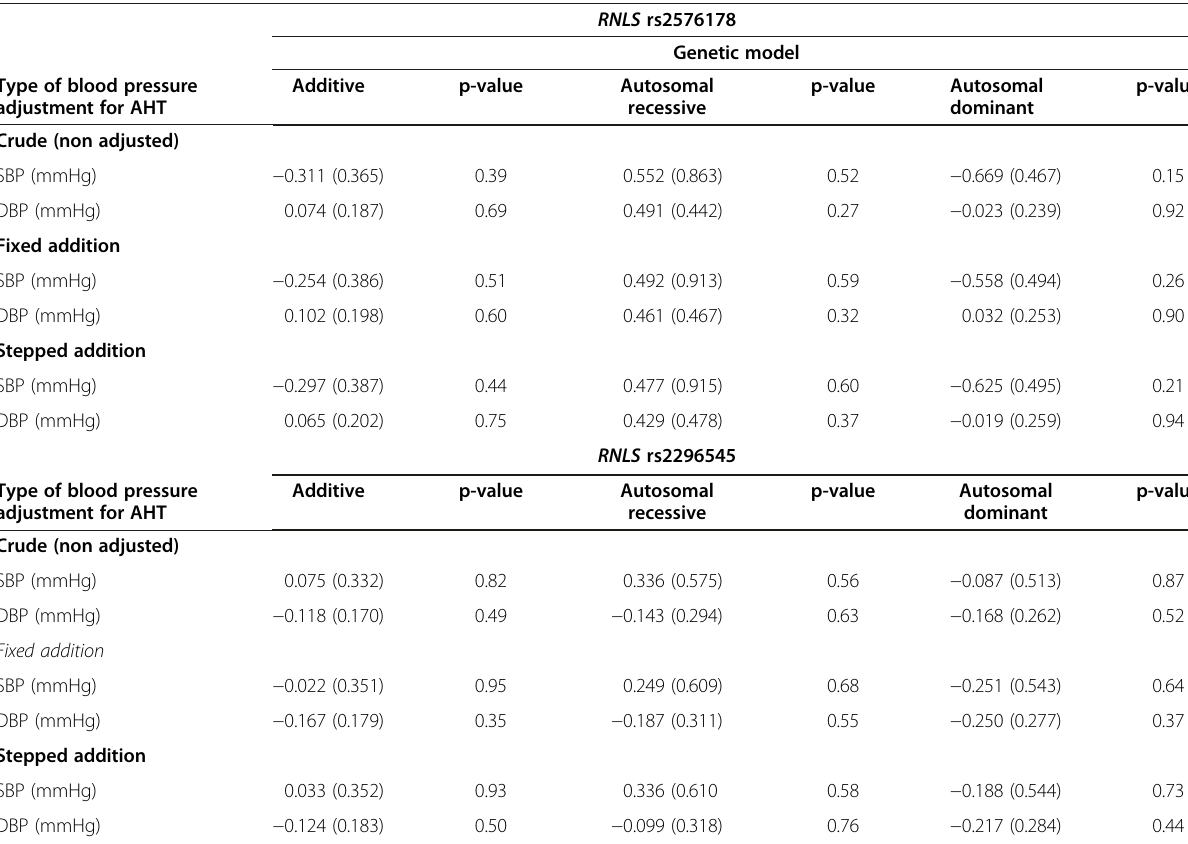
Table 3 Association between RNLS rs2576178 A > G and rs2296545 C > G polymorphisms and BP according to different genetic